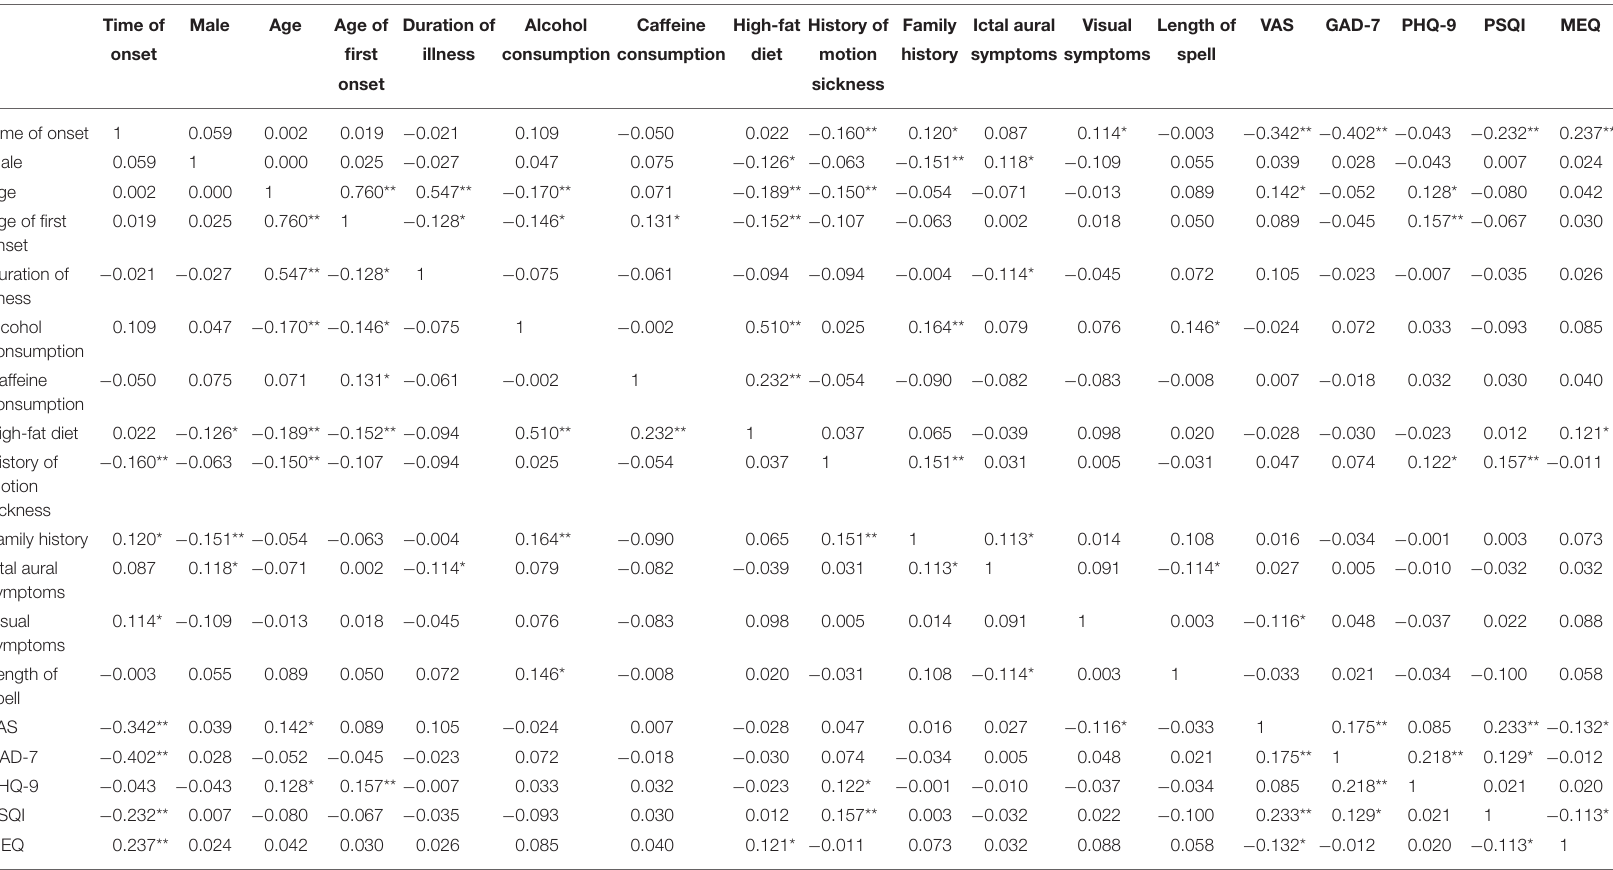
TABLE 4 | Pearson correlation coefficients between the